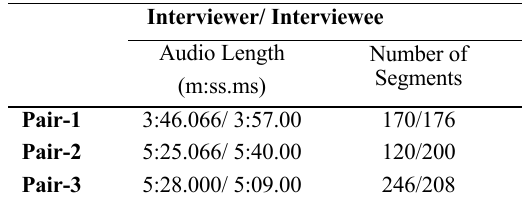
Table 1. Audio length and the number of segments for each par- ticipant’s recording.